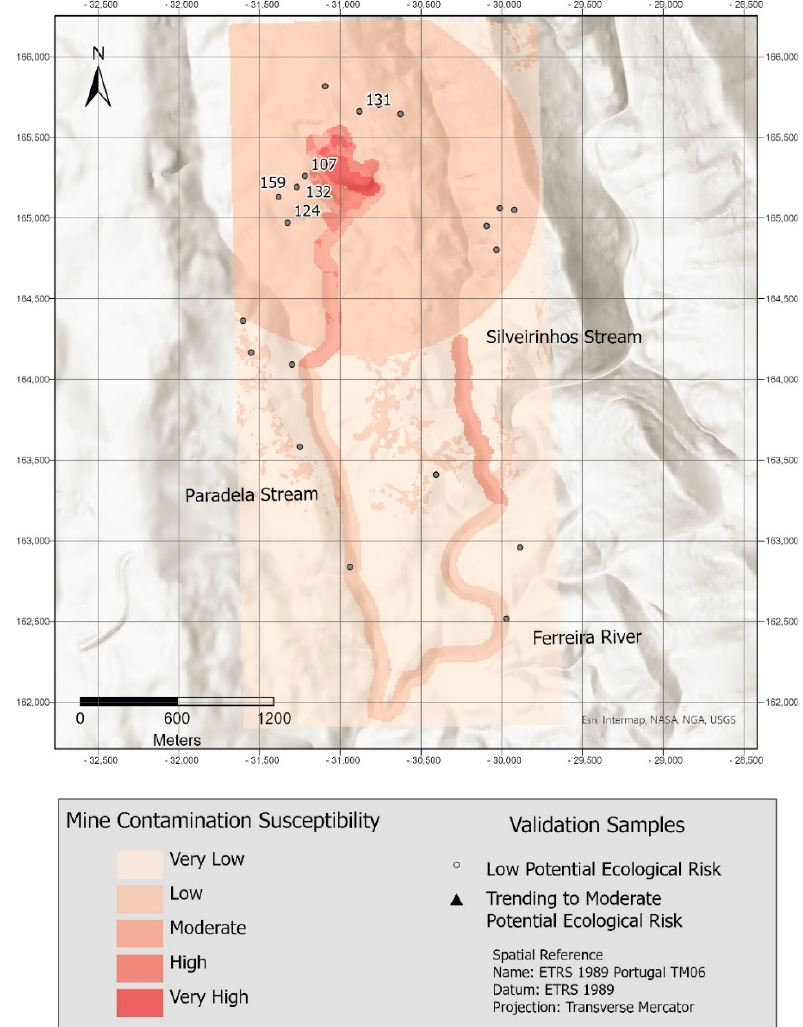
Figure 6. Sample points used for validation.